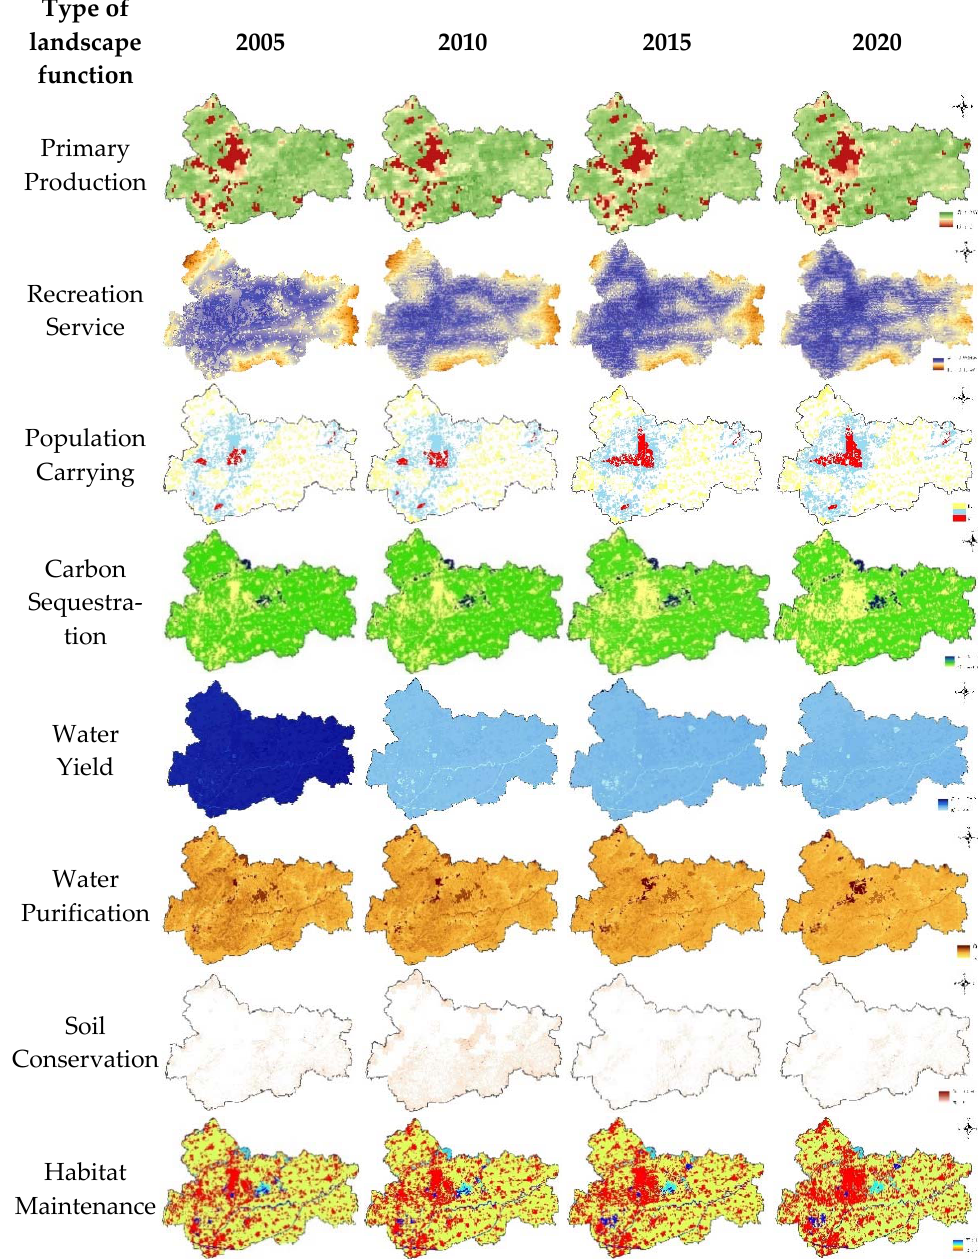
Figure 5. Spatial pattern of landscape functions in 2005, 2010, 2015, and 2020.